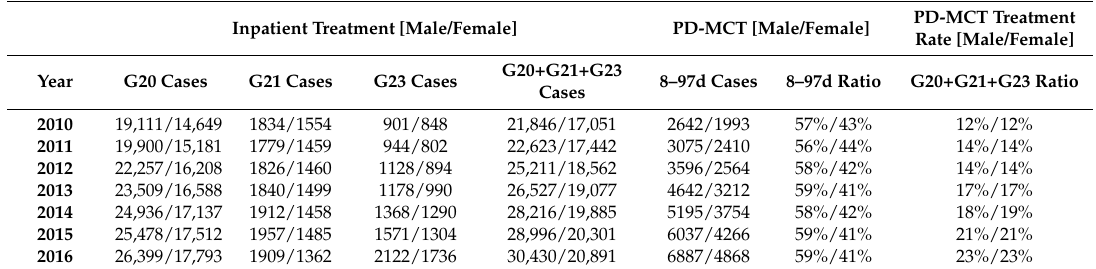
Table 4. Data and treatment rates for PD-MCT separated into ICD subcategories.